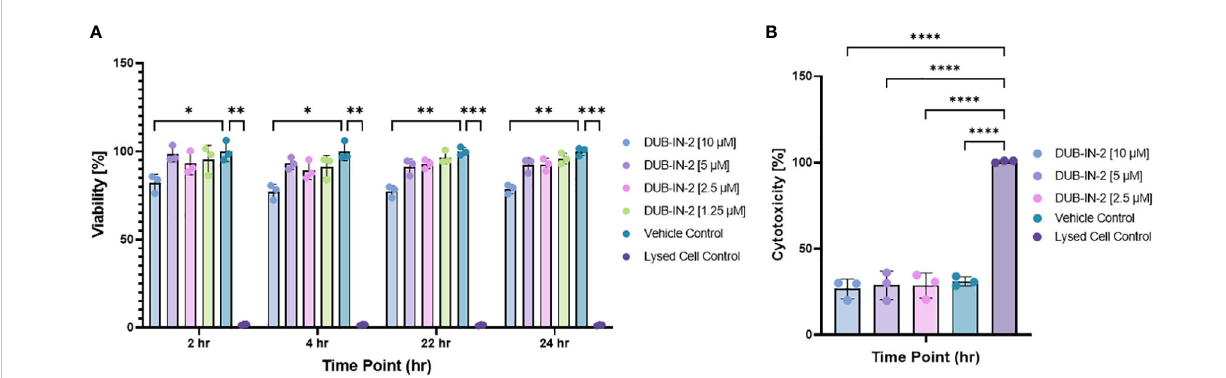
FIGURE 3 (A) Effect of USP8 inhibition on cell viability during infection with Salmonella . MultiTox-Fluor Multiplex Cytotoxicity assays were performed using four increasing concentrations of DUBs-IN2 inhibitor in THP-1 macrophages as indicated on the fi gures. Cells were treated with either vehicle control or DUBs-IN2 for either a 2- or 24-hour period, after which the assay buffers were added and incubated for 30 minutes before fl uorescence was read on the Cytation3 Imaging Reader. The viability was calculated relative to the Vehicle control (100%), and the signi fi cance was established by One- way ANOVA test followed by multiple testing corrections, where the signi fi cance shows the differences between the vehicle control and each separate treatment The number of independent replicates for this experiment was 3 (n=3). (B) . Effect of USP8 inhibition on cell cytotoxicity during infection with Salmonella . Cells were subjected to the infection and DUBs-IN2 inhibitor treatment as indicated above. The cytotoxicity was measured by using MultiTox-Fluor Multiplex Cytotoxicity assay at 24 hours post-infection and shown as % where Lysed Cell Control represents 100% cytotoxicity. The signi fi cance was established by One-way ANOVA test followed by multiple testing corrections, where the signi fi cance shows the differences between each treatment. The number of independent replicates for this experiment was 3 (n=3). P-values were indicated as follows: